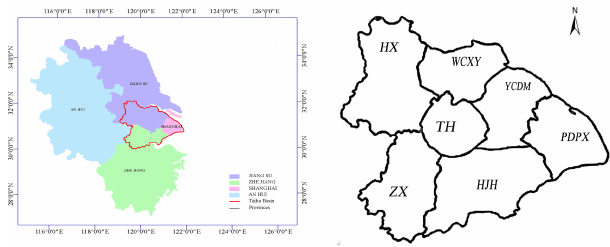
Figure 1. Taihu Basin and its sub-regions in